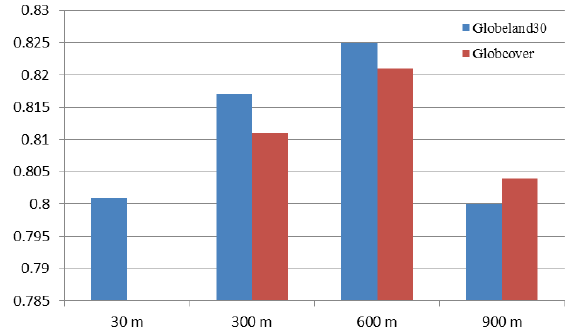
Figure 3. Comparison of AUC scores of MaxEnt models created with Globeland30 and Globcover.